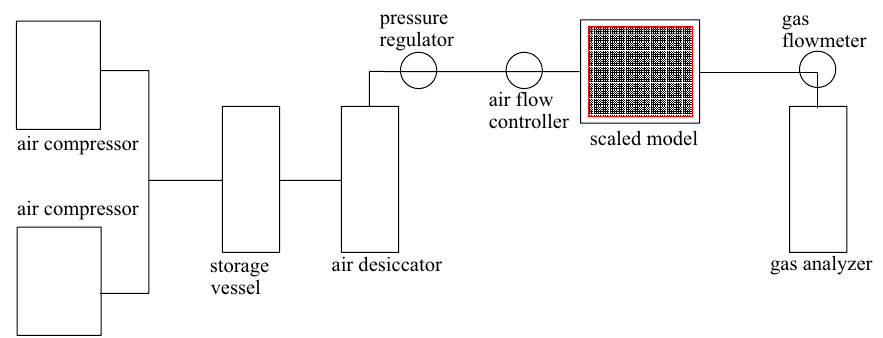
Fig. 1 The scaled physical experimental system of ISC